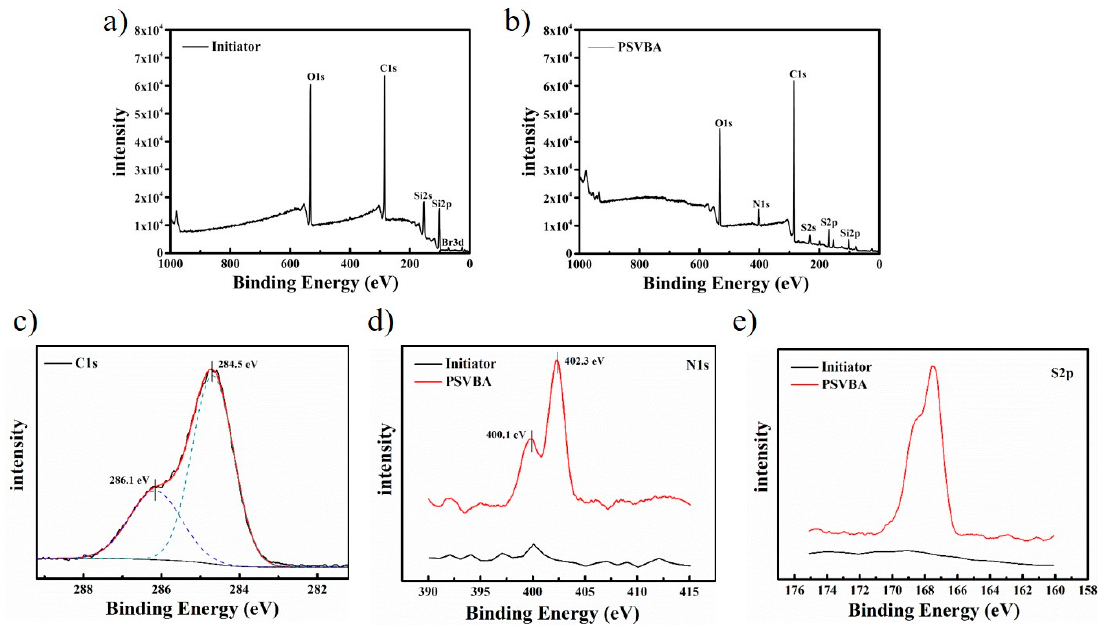
Figure 3. X-ray photoelectron spectroscopy (XPS) survey spectra of silicon surfaces grafted with ( a ) initiators and ( b ) polySVBA (PSVBA) brushes; ( c ) C 1 s , ( d ) N 1 s , and ( e ) S 2 p high-resolution survey scans.